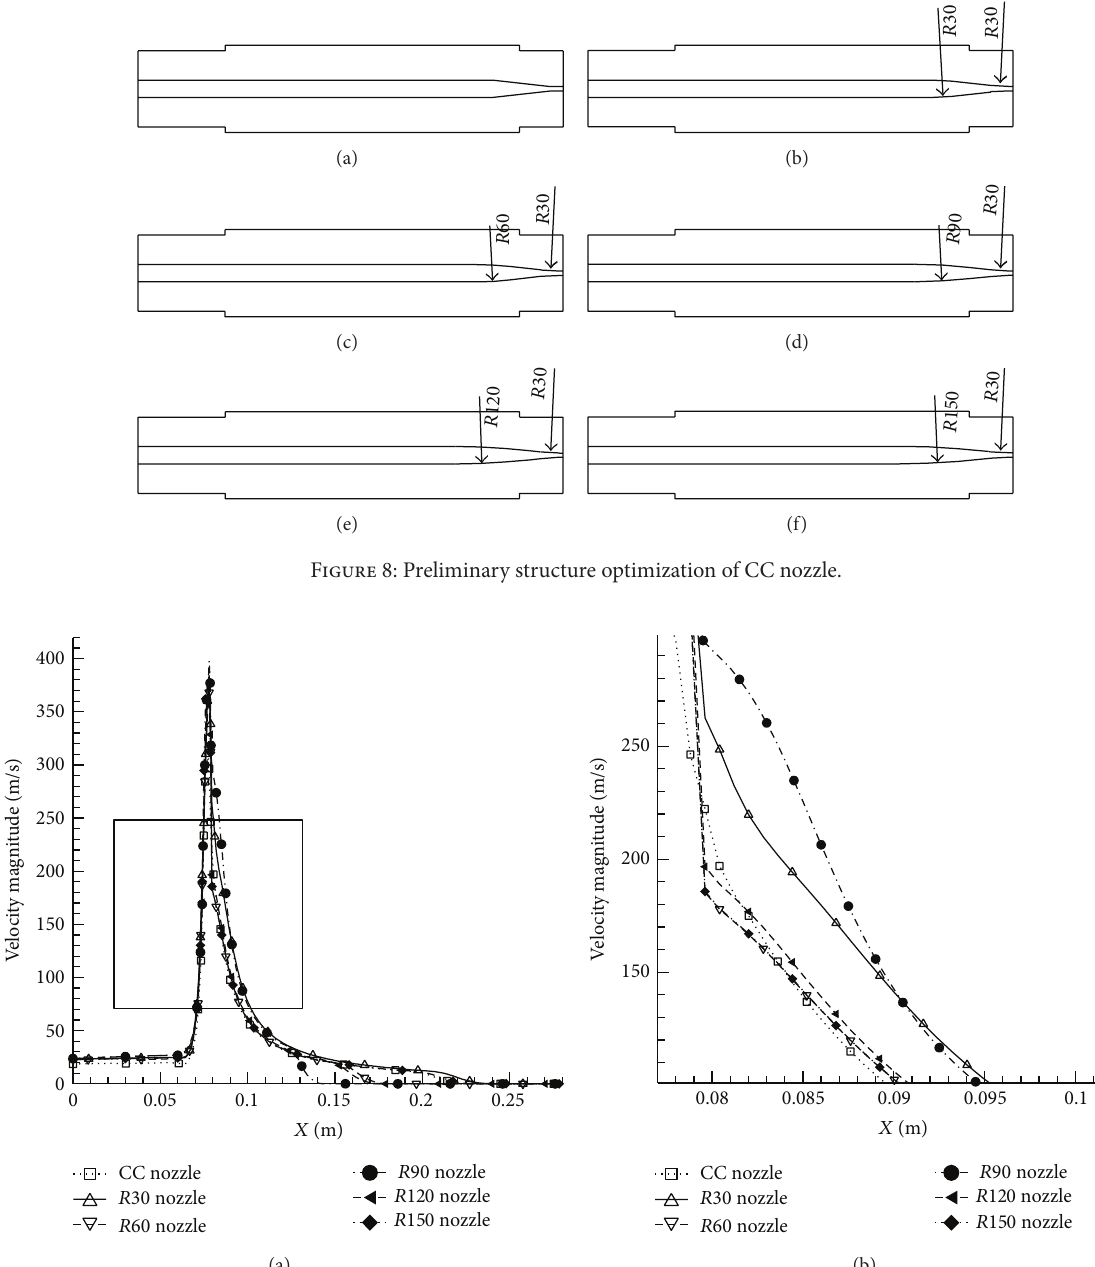
cleaning range of the helix nozzle was about 0.078–0.143